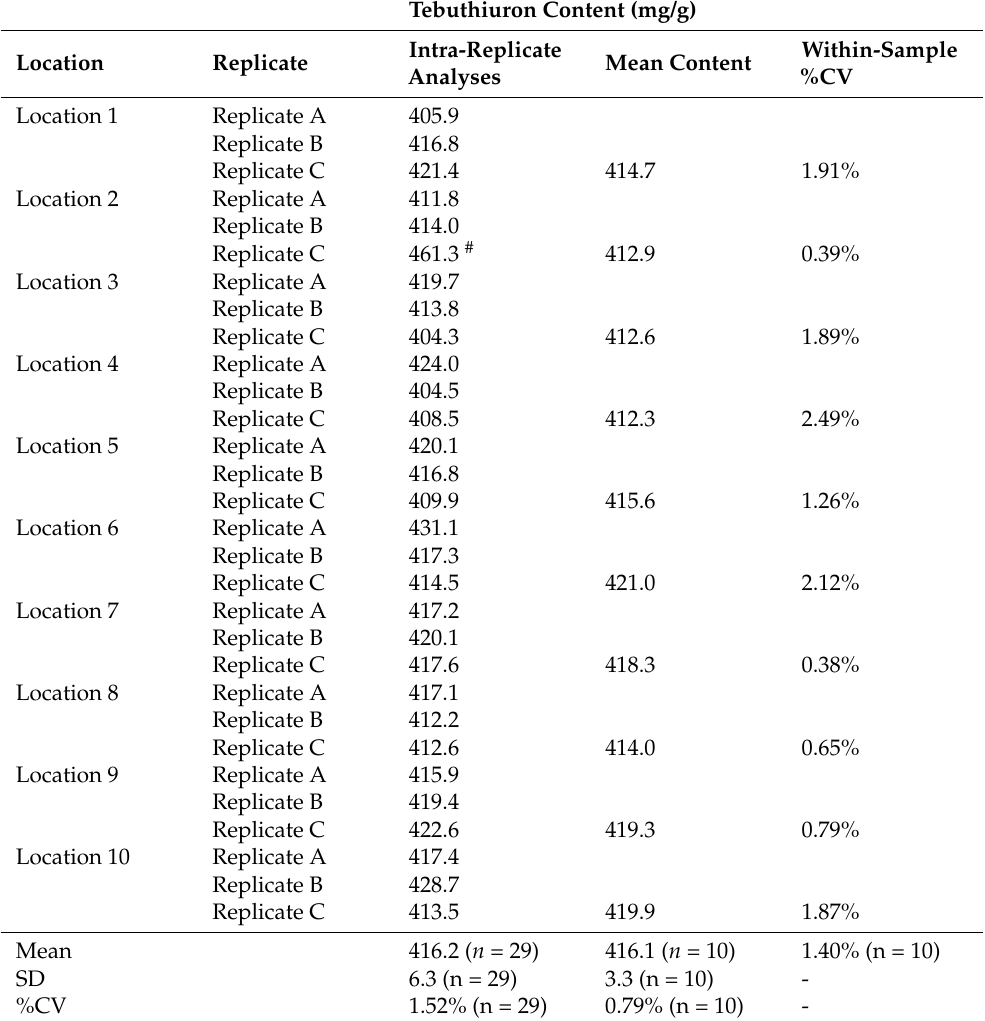
Table 4. Assessment of the variation in tebuthiuron content between different portions of one Regain400